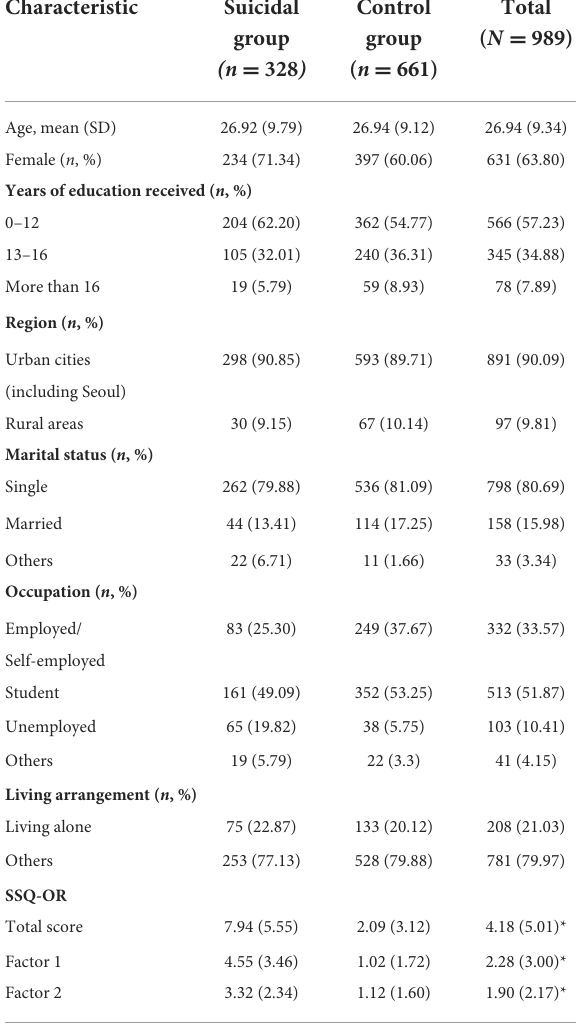
TABLE 1 Demographic characteristics of the study sample and scores of suicide screening questionnaire-observer rating (SSQ-OR).